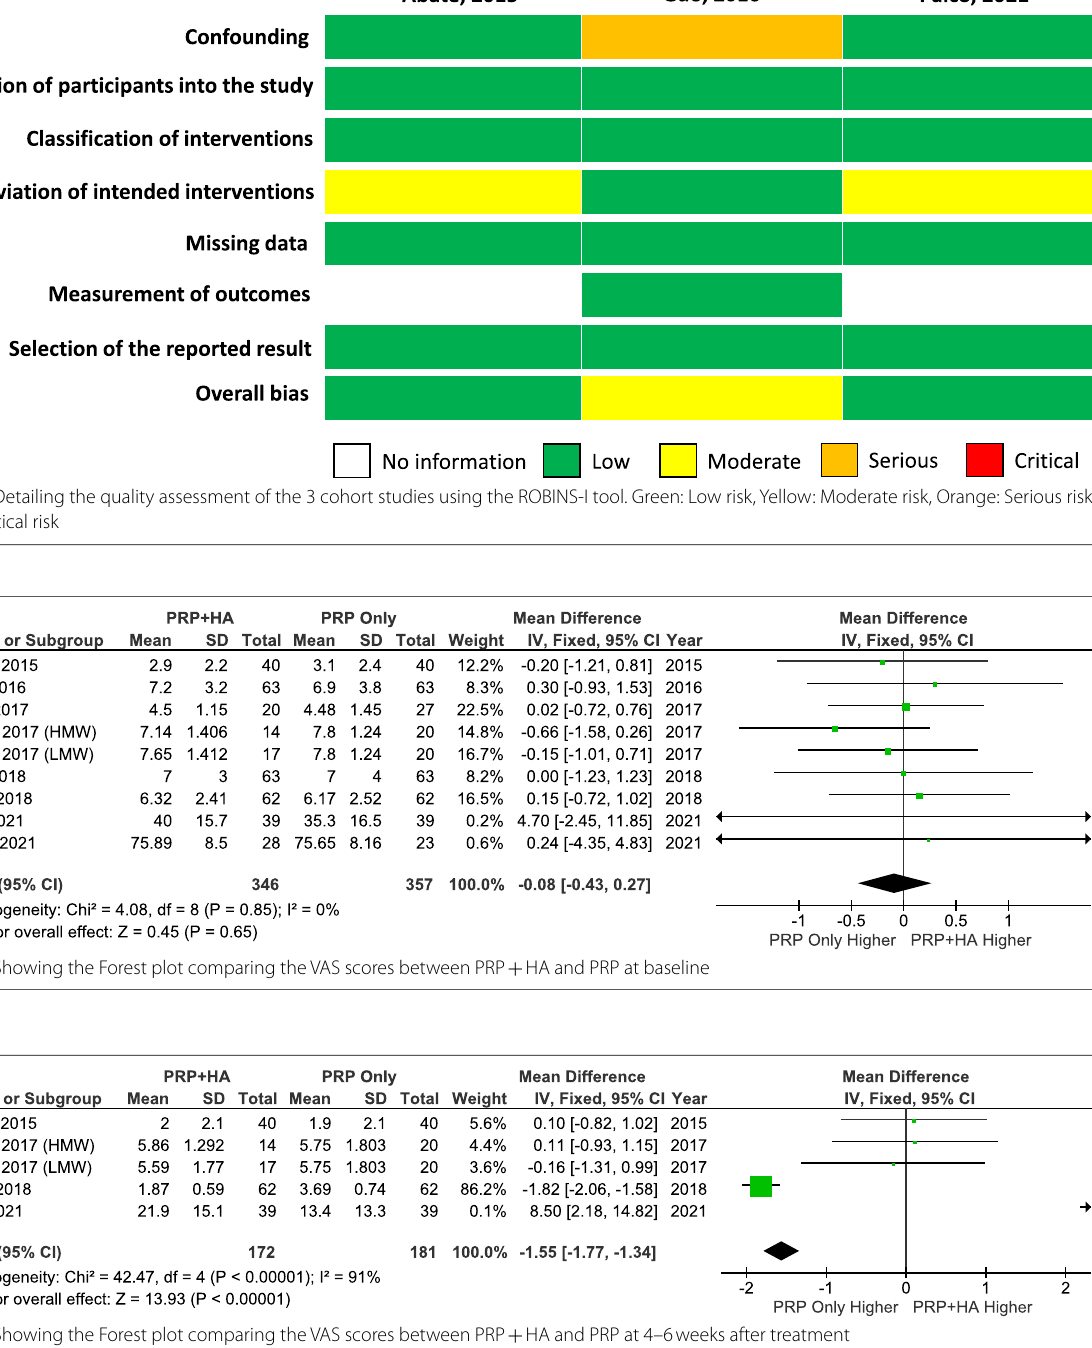
A comparison of WOMAC function scores between PRP combined with HA and PRP pre-treatment and post- treatment showed a significant mean improvement of 4.07 points (95% CI: − (Fig. 14).